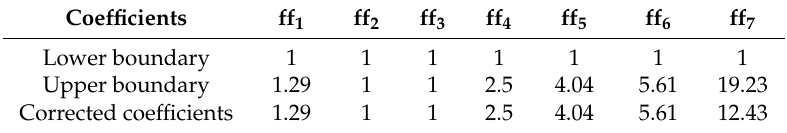
Table 19. The boundaries and correction results of the state variables